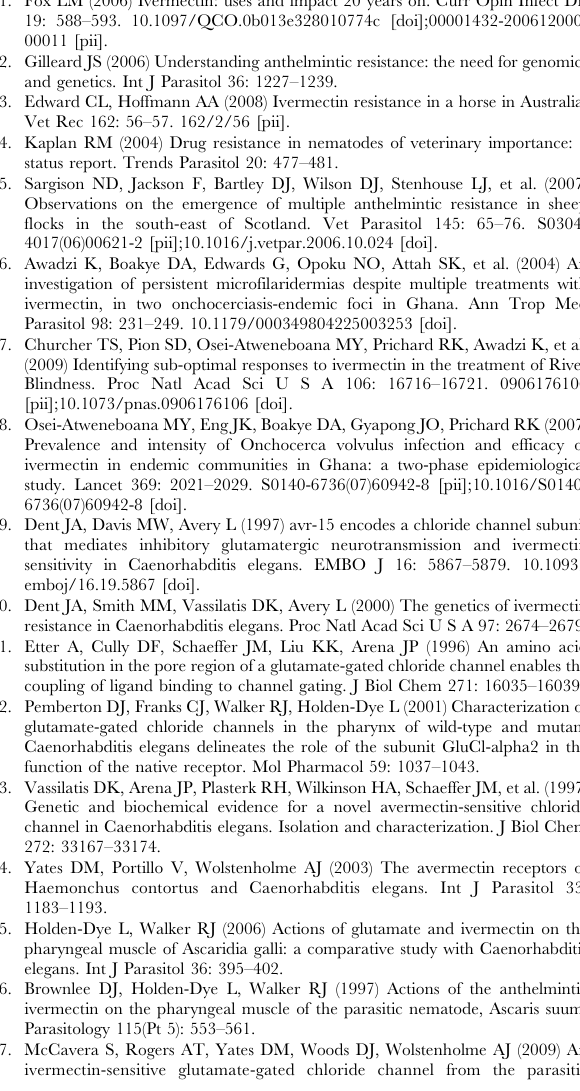
Table S5 Log fold change in expression of ‘‘classic’’ stress response genes following IVM exposure (1 m